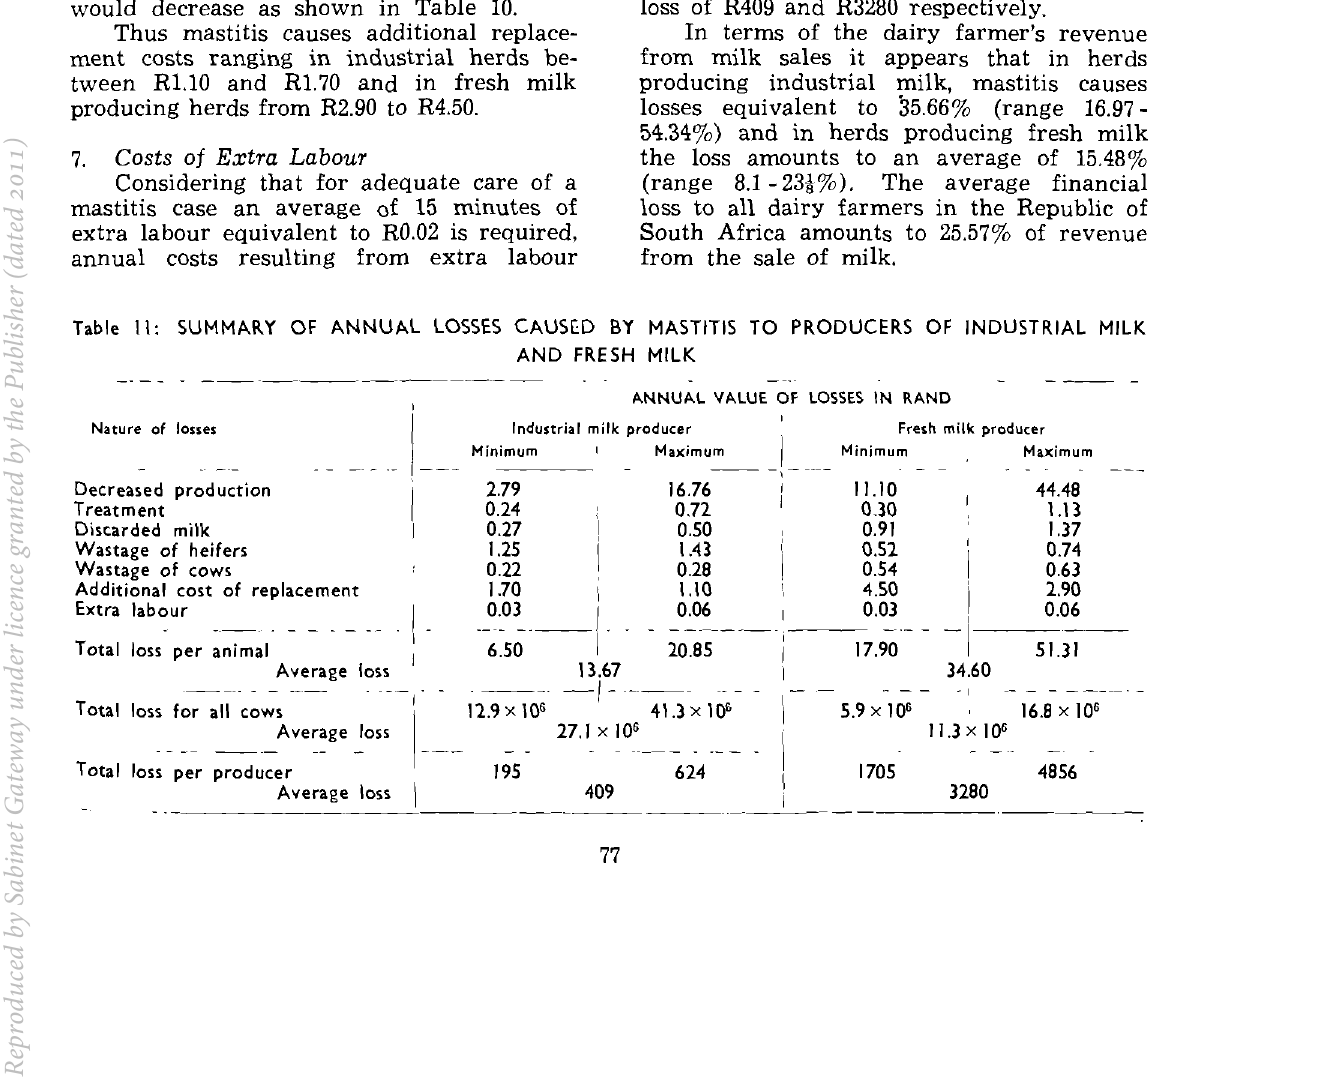
Table II: SUMMARY OF ANNUAL LOSSES CAUSED BY MASTITIS TO PRODUCERS OF INDUSTRIAL MILK AND FRESH MILK